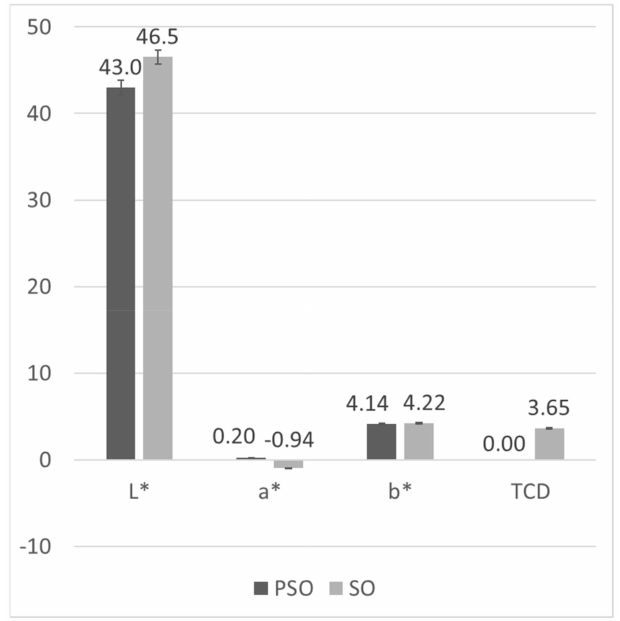
Figure 3. CIE colourimetric parameters of samples of laboratory-pressed PSO and refined SO (columns represent means and error bars represent standard deviation of n = 3 replications). The brightness or L* value represents a scale from 0 to 100, ranging from black to